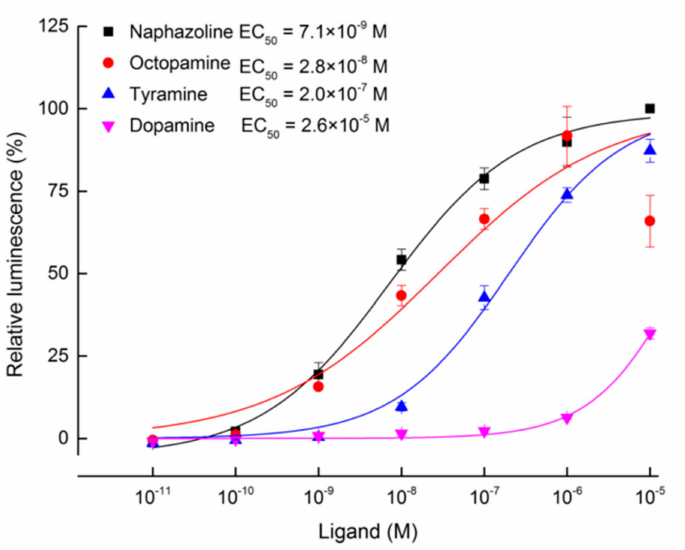
Figure 3. Dose–response curves of TcOct β 2R transiently expressed cells (HEK 293) to four tested ligands (naphazoline, octopamine, tyramine, and dopamine). Each spot represents the mean relative luminescence ± S.E. from three biological replications. The relative luminescence was normalized to the luminescence caused by the application of naphazoline at 1.0 × 10 − 5 M.